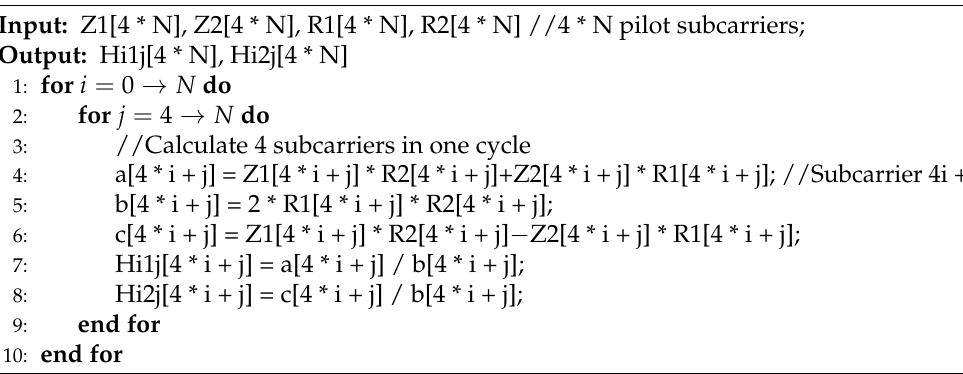
Algorithm 1 LS estimation